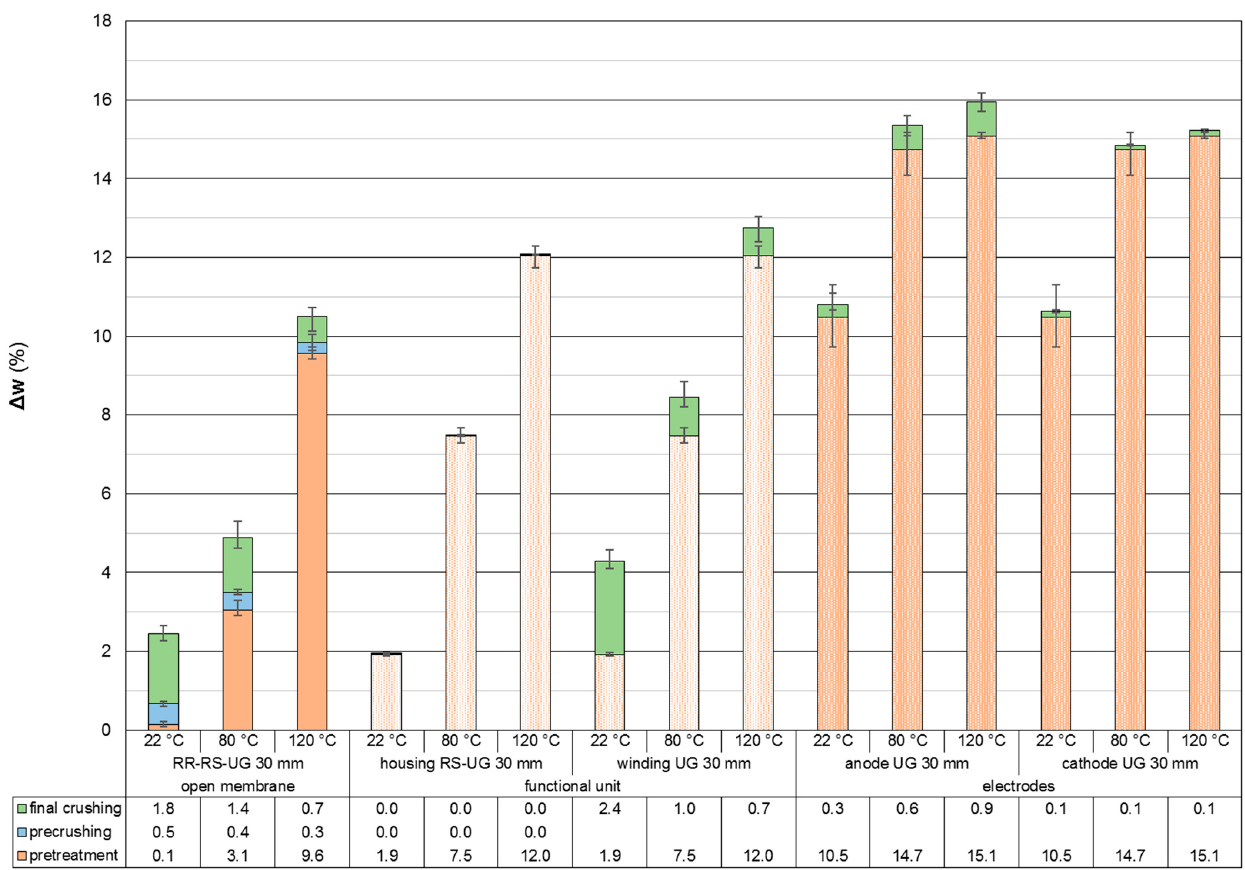
Figure 6. Relative mass difference during liberation of pretreated cells and components (error bars indicate minimum and maximum); the shaded columns represent the relative mass difference during pretreatment for both components of the respective dismantling depth.